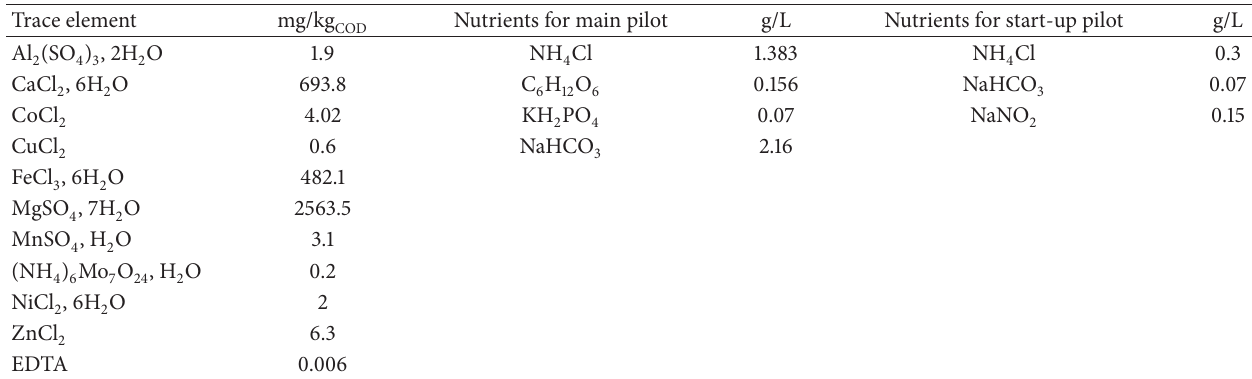
Table 1: The composition of the mineral